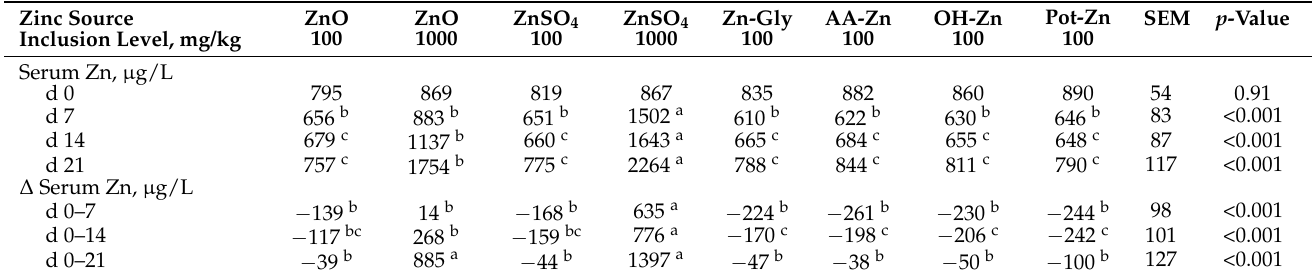
Table 5. Serum Zn ( µ g/L) on d 0, d 7, d 14 and d 21 post-weaning and the change in serum Zn ( ∆ Serum Zn) from the day of weaning (d 0) to d 7, 14 or 21. Least-square mean values with their standard errors, n = 12/treatment ( n = 11 for ZnSO 4 at 1000 mg/kg and Pot-Zn).